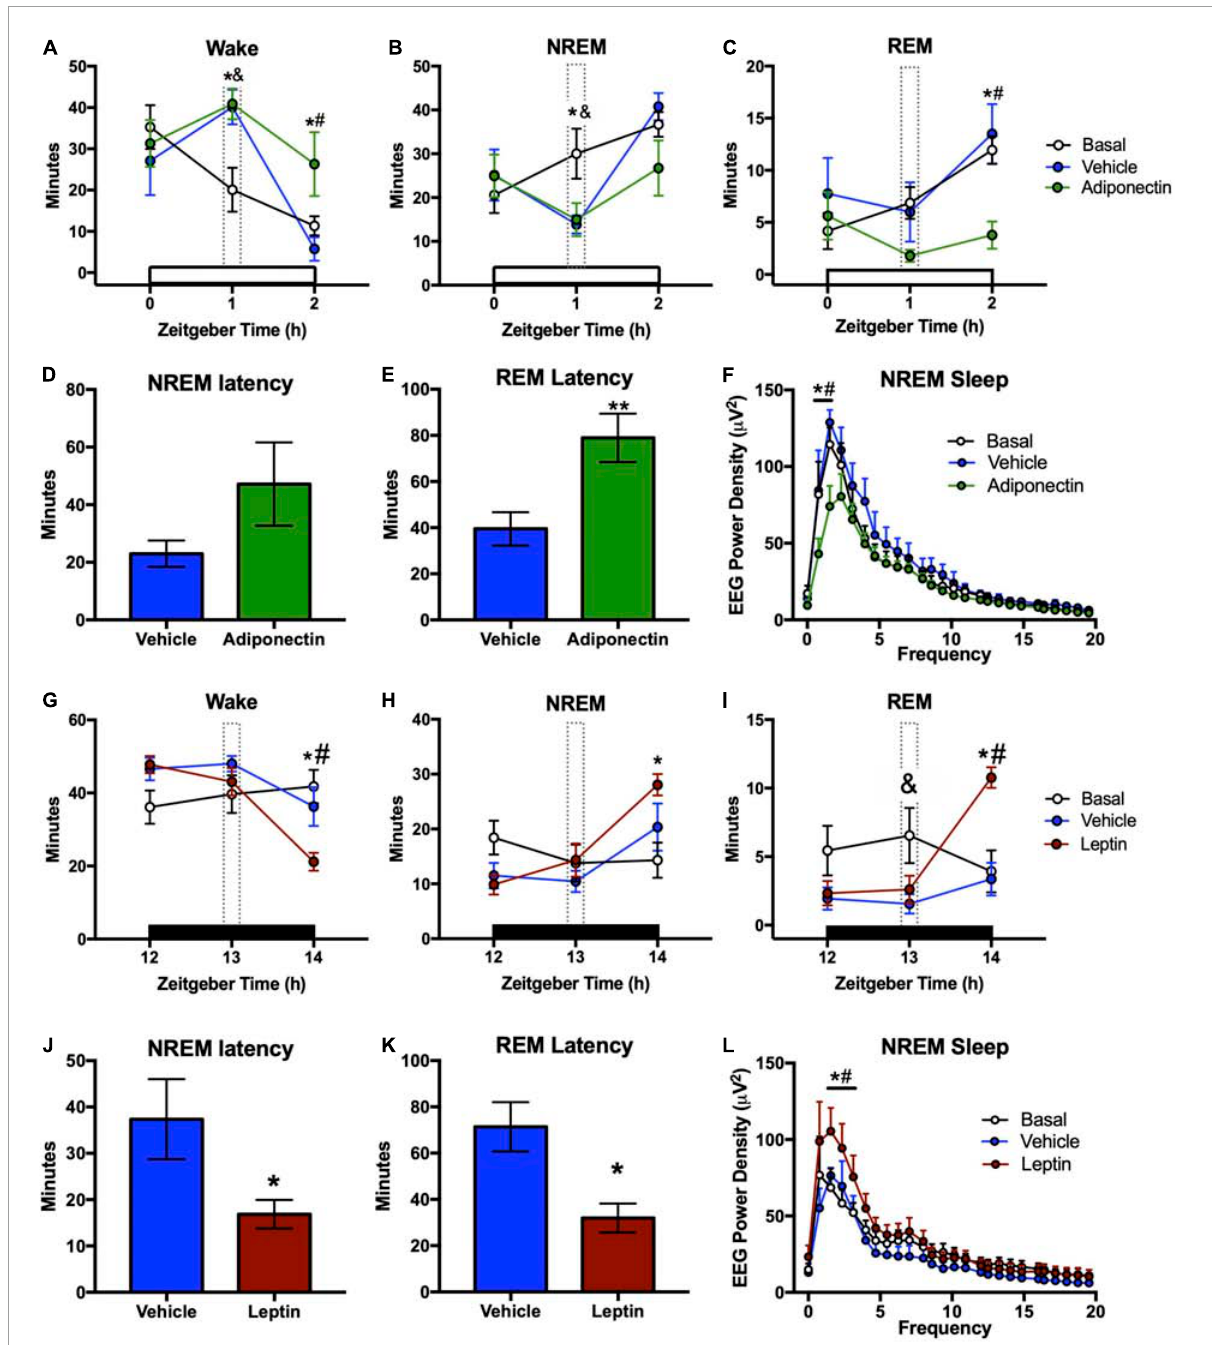
FIGURE5 Sleep-wake times and latency after adipokines administration. Wake, NREM, and REM time after (A–C) adiponectin or (G–I) leptin administration. (D) NREM and (E) REM latencies from the moment of (D,E) adiponectin or (J,K) leptin microinjection. Change in delta power during NREM sleep after (F) adiponectin or (L) leptin administration. In sleep-wake graphs: white bar, light phase; dark bar, dark phase; dotted line, hour of adipokine administration; * P < 0.05 adipokine vs. basal; & P < 0.05 vehicle vs. basal; # P < 0.05 adipokine vs. vehicle. In latency graphs: * P < 0.05, ** P <